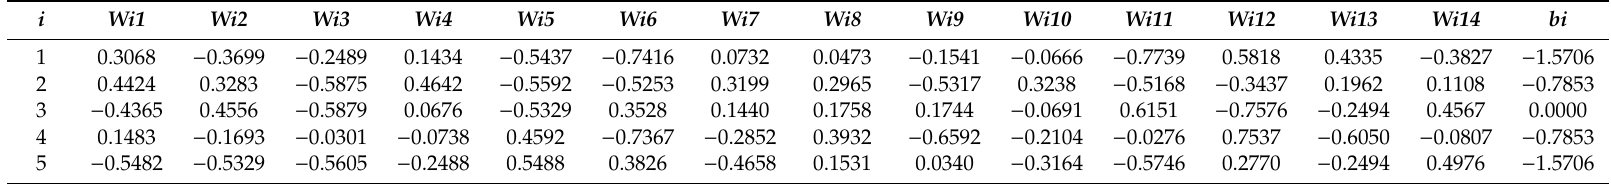
Table 4. The computational weights and biases of the MLP optimized by BBO